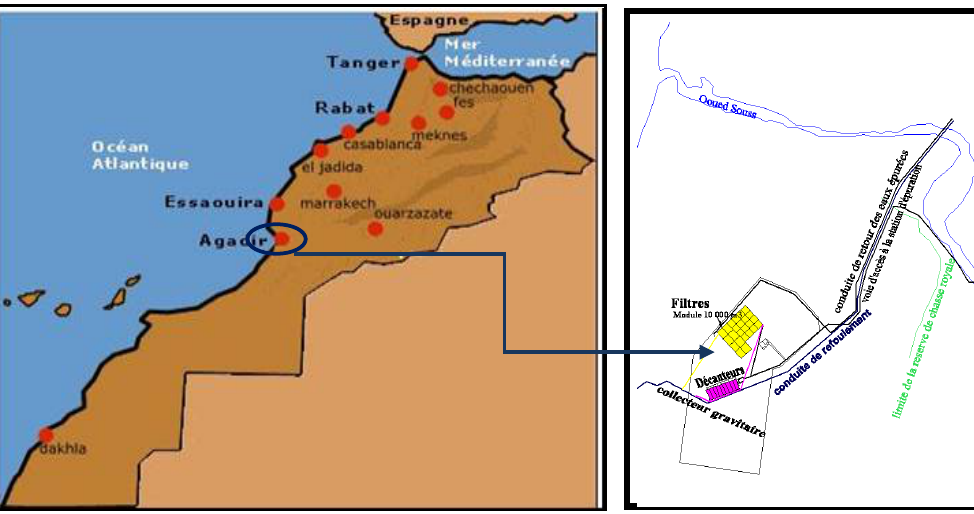
Figure 1. Localization of the M’zar plant of